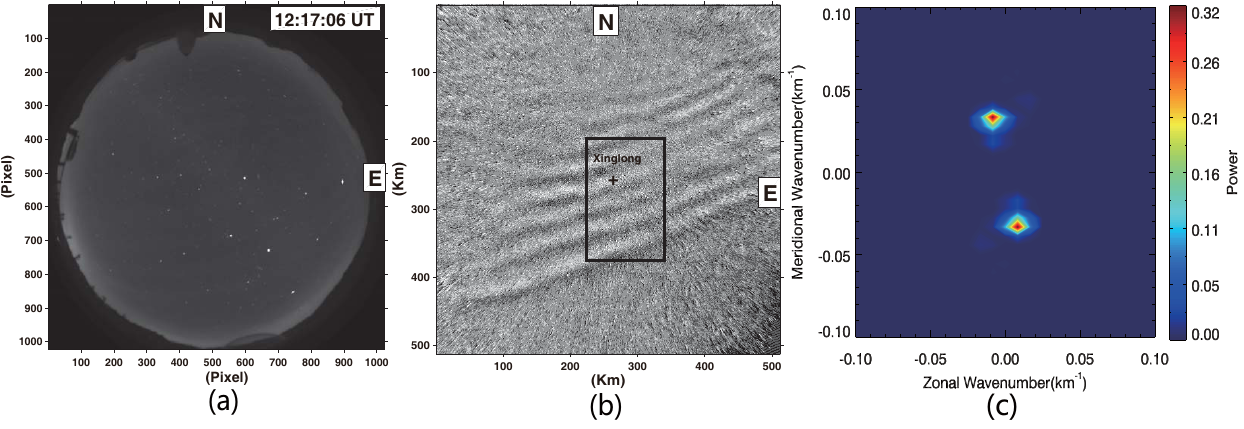
Fig. 2. (a) A 1024 × 1024 pixels OH airglow raw image observed on the night of 15 January 2010 at 12:17UT (20:17LT), (b) an unwrapped TD image corresponding in an area of 512 × 512km, (c) the power spectrum of the rectangular area (120 × 180km) in Fig.